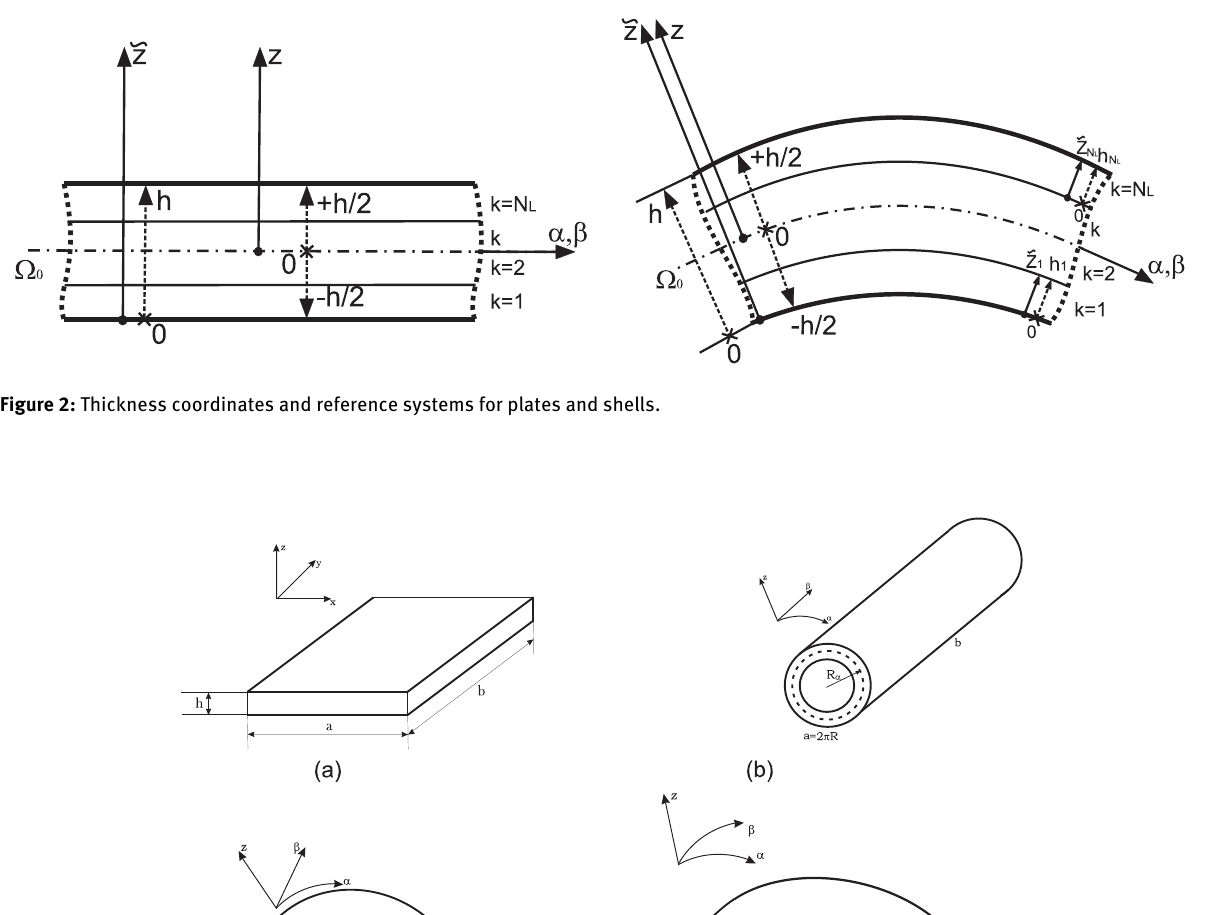
The geometrical relations written for shells with constant radii of curvature are obtained from the general strain- displacement relations of the three-dimensional theory of elasticity in orthogonal curvilinear coordinates proposed in [39] and